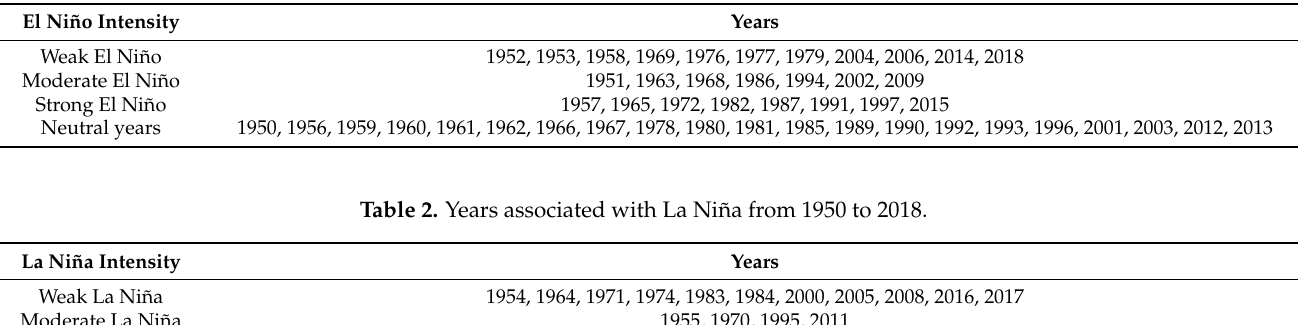
Table 1. Years associated with El Niño from 1950 to 2018.